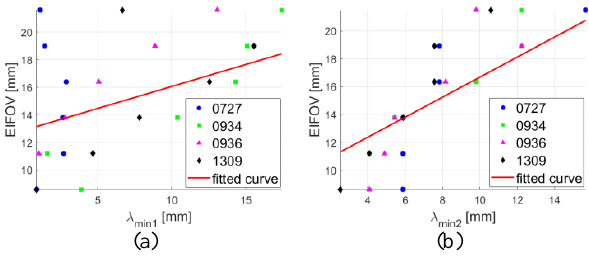
Fig. 7. Smallest extractable detail size λ min versus EIFOV (a) λ min1 and (b) λ min2 λ min2 shows stronger linear relation to EIFOV, this is having higher ρ 2 then λ min1 . Therefore λ min2 can be considered as a more reliable measure of effective resolution on irregular surface. For Fig. 6. Representative similarity measures for sample 1309 the analysed R from 10 to 60 m, λ min is smaller than EIFOV. versus grid size, λ j (a) Mean relative difference of Grasselli Shorter is the R , more pessimistic is the theoretical value parameters, 𝑒𝑟𝑟𝑜𝑟 𝑘,𝑗 , and (b) standard deviation of height EIFOV. differences, std( Δ𝑍 𝑘,𝑗 )